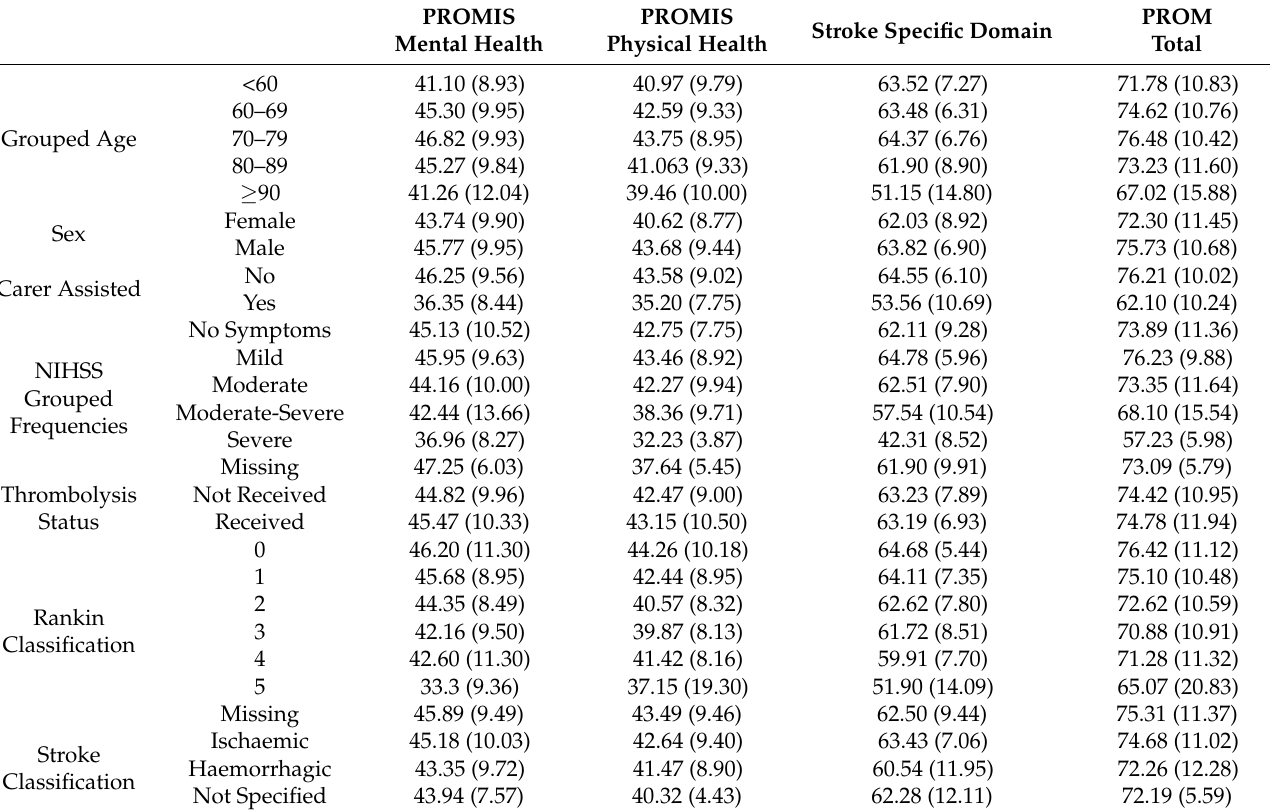
Table 2. Clinical characteristics of the PROM domain score mean